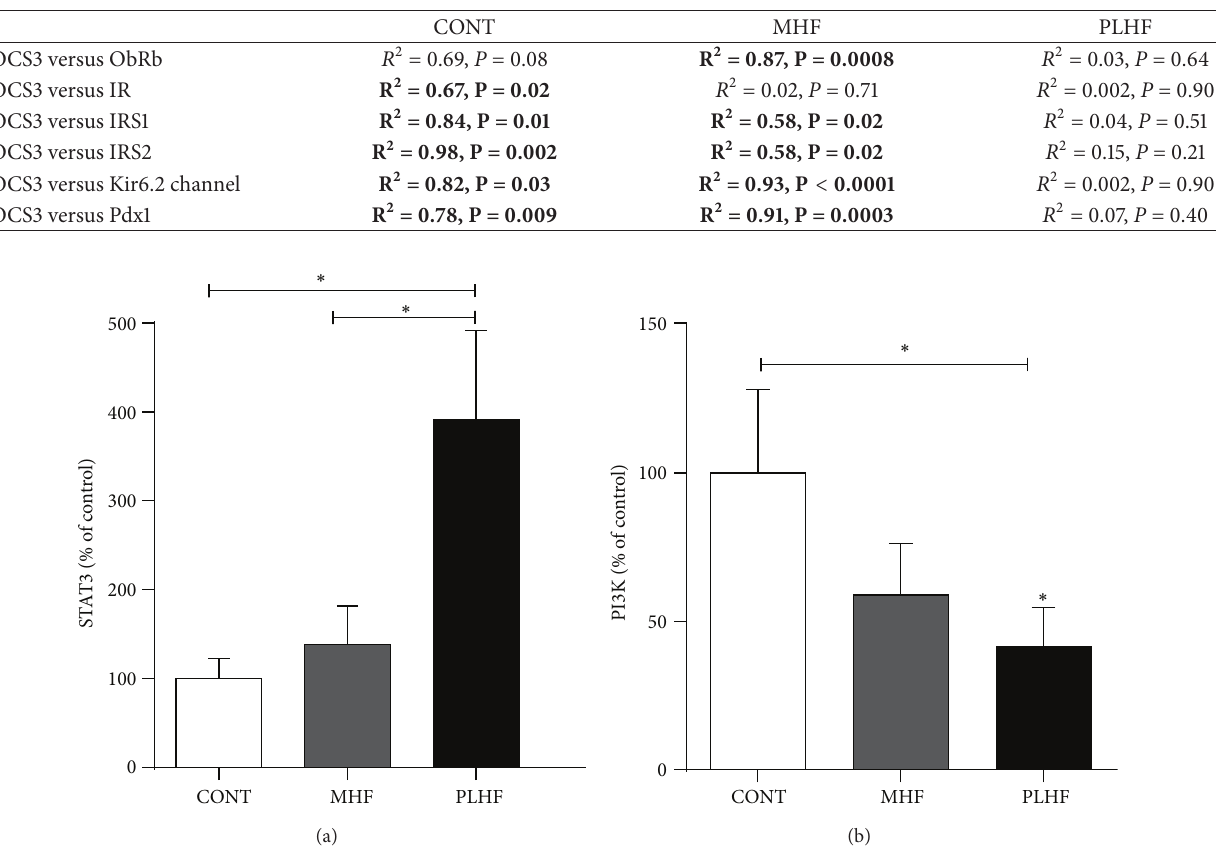
Table 2: Correlations between SOCS3 and other key genes. N = 8–13 per group.